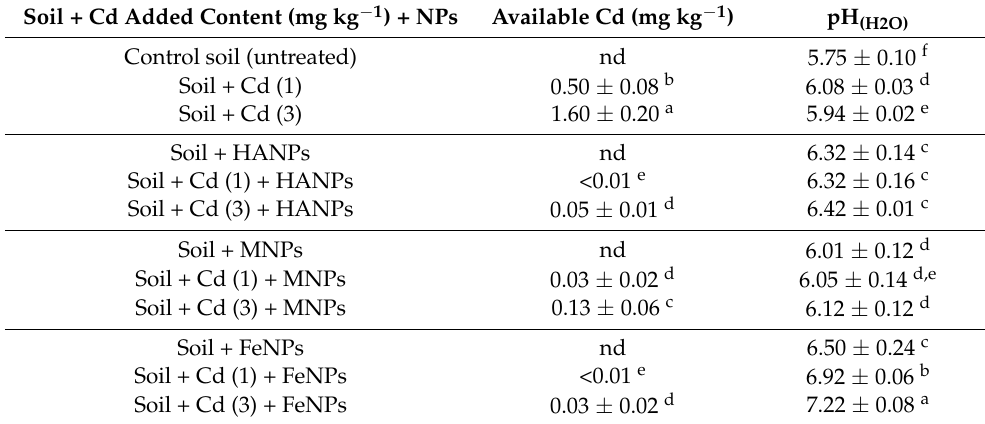
Table 2. Available Cd contents in untreated and treated soils with Cd and/or nanoparticles and pH after each